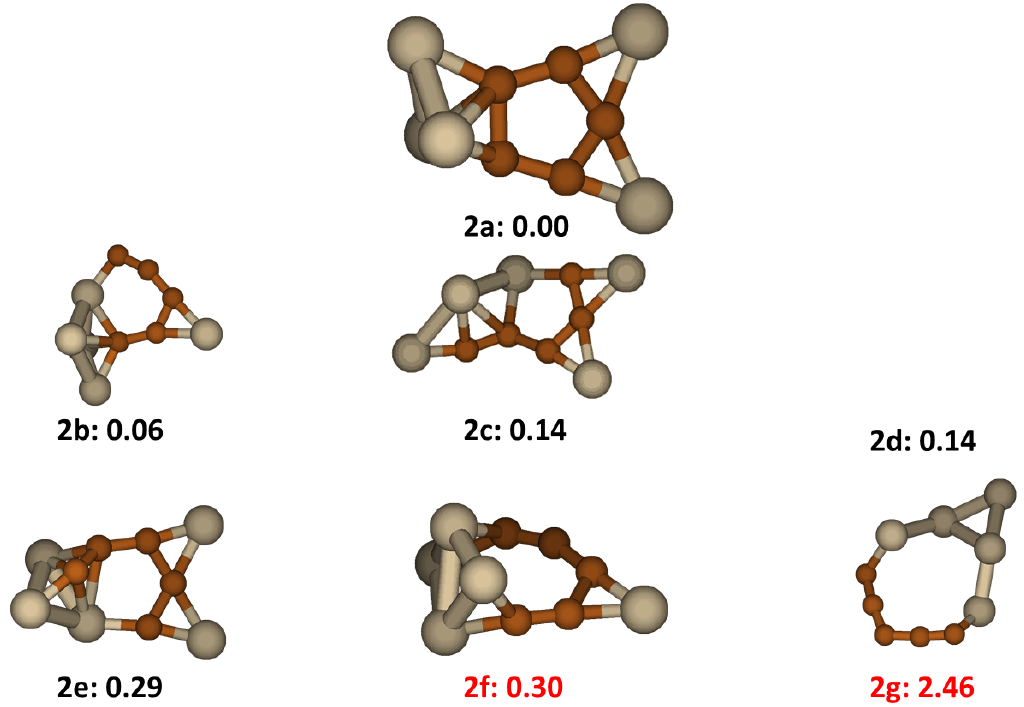
Figure 2. The structures and relative energies (in eV) of the lower energy Si Structure 2f and 2g are previously reported in ref. [17] and ref. [19],